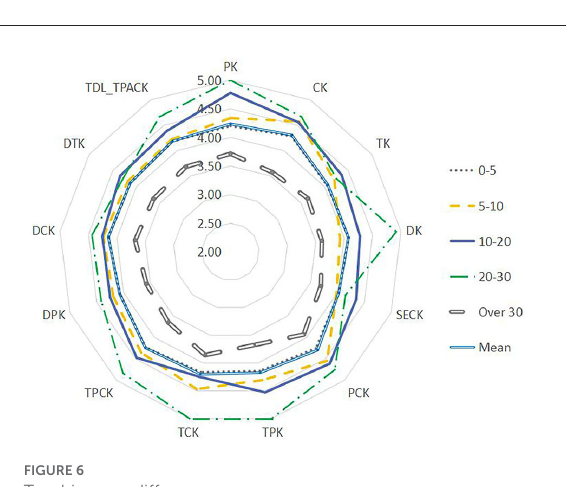
FIGURE6 Teaching age